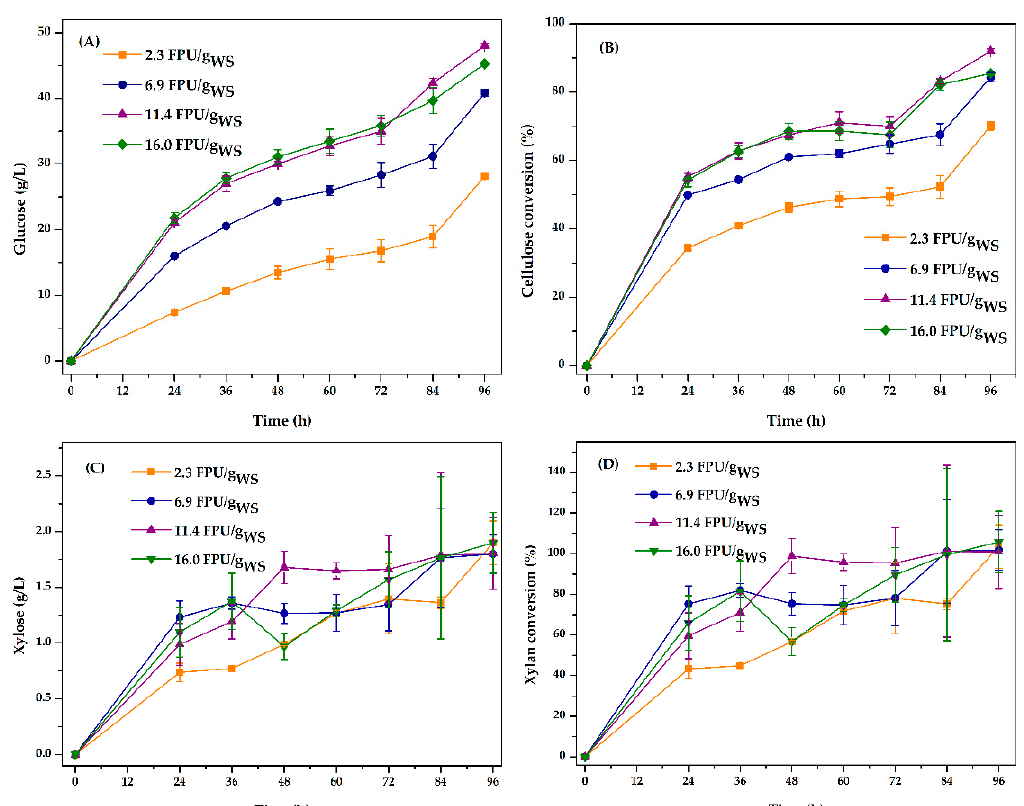
Figure 2. Enzymatic saccharification of DES pretreated WS under different enzyme loadings at a solids content of 8% ( w/v ) in citric buffer solution for 96 h. ( A ) Glucose concentration, ( B ) cellulose conversion, ( C ) xylose concentration, and ( D ) xylan conversion.